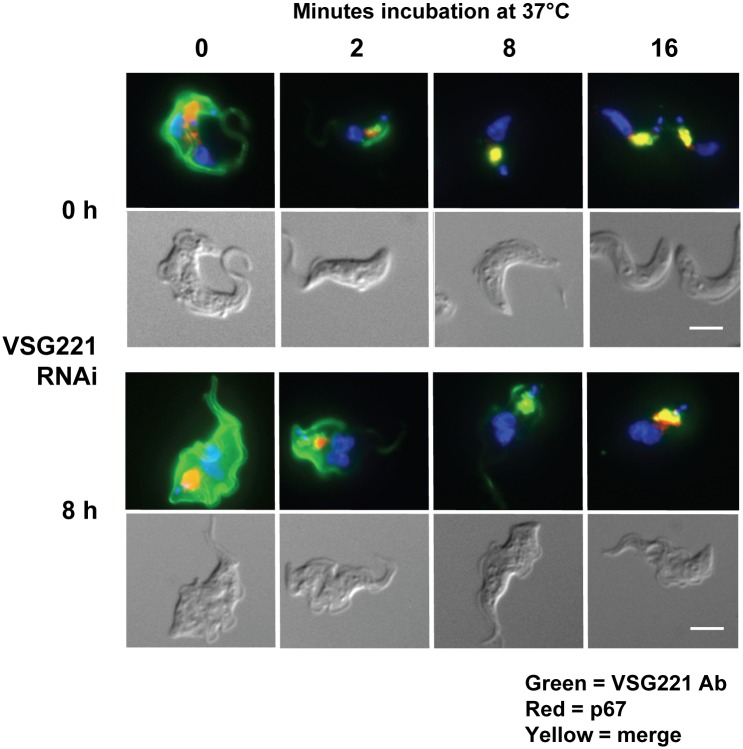
Blocking VSG synthesis results in impairment of internalisation of anti-VSG antibodies.Reduced rates of internalisation and lysosomal degradation of anti-VSG221 antibody after induction of a VSG221 synthesis block. VSG221 synthesis was blocked in T. brucei 221VB1.2 cells by the induction of VSG221 RNAi for 8 hours (h). Cells were coated with an anti-VSG221 antibody at 4°C to stop endocytosis, and then transferred to 37°C to activate endocytosis for the time shown in minutes. The lysosomal thiol protease inhibitor FMK-024 was used to inhibit degradation of anti-VSG antibody in the lysosomal compartment, and facilitate its visualisation. Cells were then fixed and stained with an Alexa Fluor 488 coupled secondary antibody. The lysosomal compartment was visualised with an antibody against the p67 lysosomal protein stained with an Alexa Fluor 594 coupled secondary antibody. The merge of the two signals is shown in yellow. Below are shown panels of the trypanosomes visualised using differential interference contrast. Scale bar: 5 μm.